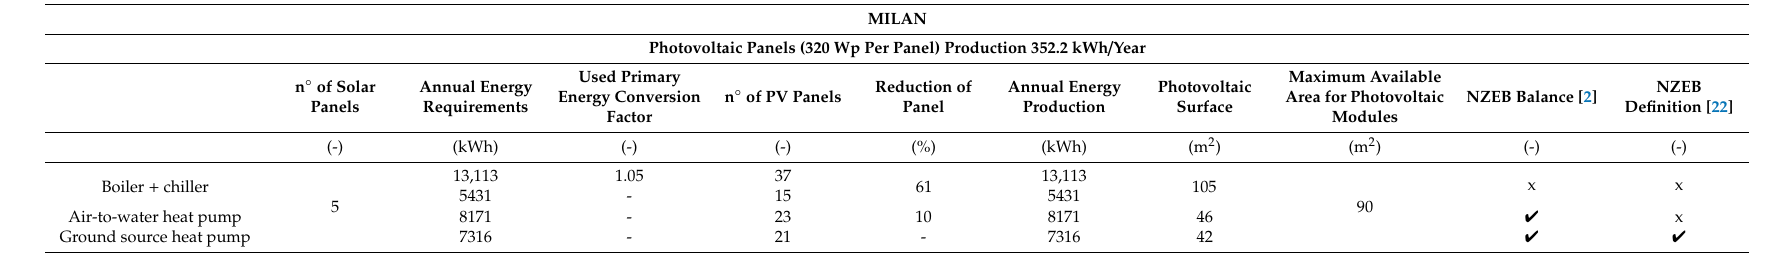
Table 8. Yearly energy balance for obtaining a NZEB in the case of